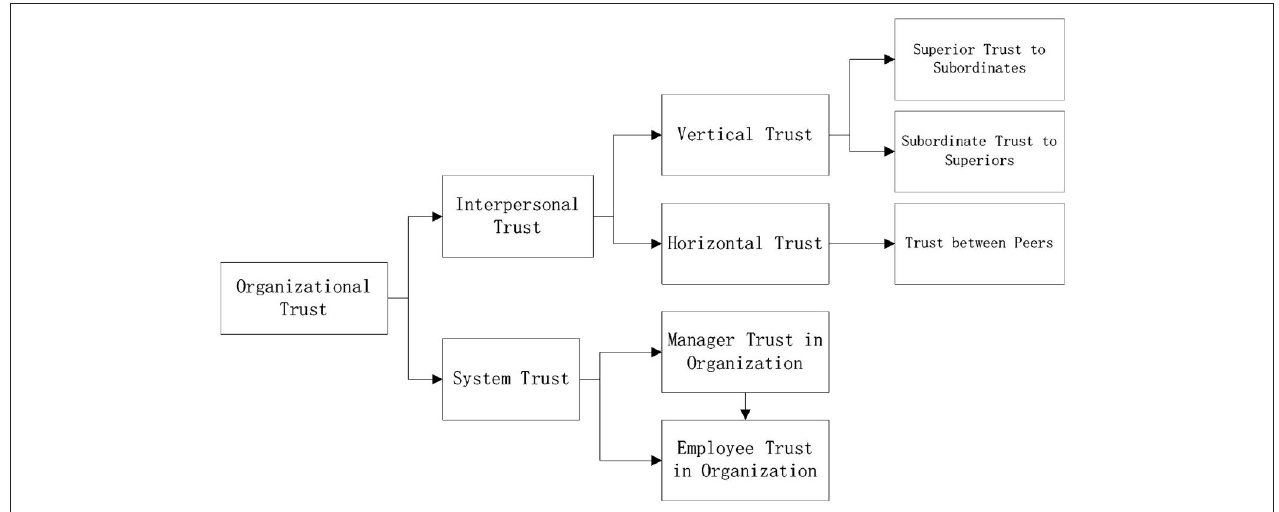
FIGURE 1 | Organizational trust